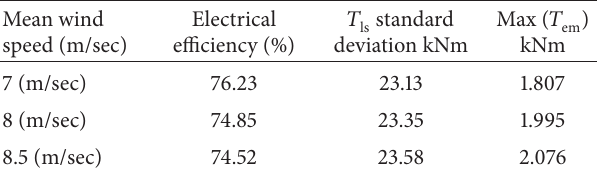
Table 4: MNSSFE performance for different wind speed profiles. Mean wind